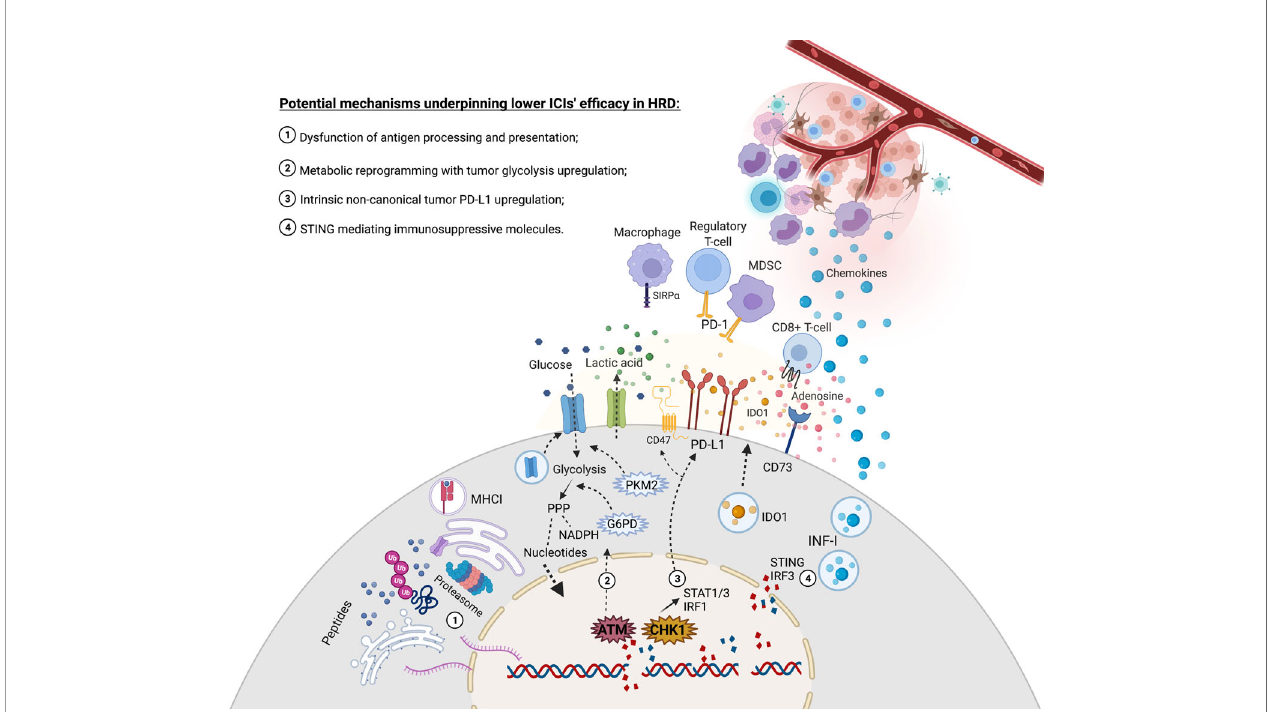
FIGURE 1 | Increased rate of DNA double strands breaks due to de fi ciency in HR might evolve with molecular events that lead to challenges in restoring immune responses through immune checkpoint inhibitors. (1) DNA double-strand breaks association with CNV and large structural genetic alterations contribute to an increased fl ux of unstable mRNA and, ultimately, proteins that may saturate critical chaperones and the proteasome complex, thus leading to a dysfunctional tumor antigen presentation. (2) ATM plays a central role in recognizing DNA strand breaks but can also upregulate glycolysis and PPP to replenish nucleotides and NADPH supply for the upcoming anabolic reactions to restore DNA damages. This metabolic regulation might deprive glucose in the tumor microenvironment and export acid lactic, impacting immune responses. (3) CHK1 is crucial to repair strands breaks but may also activate the STAT1-STAT3-IRF1 signaling pathway that contributes to upregulating PD-L1 expression. (4) Cytosolic DNA censoring can lead to STING-IRF3 production of IFN-I, which might recruit monocytes that will be further exposed to a range of tolerogenic stimuli in the tumor microenvironment. Moreover, the STING signaling pathway might induce IDO1, and the expression of IFN-I might upregulate CD73, thus contributing to producing inhibitory molecules in the tumor microenvironment. Created with